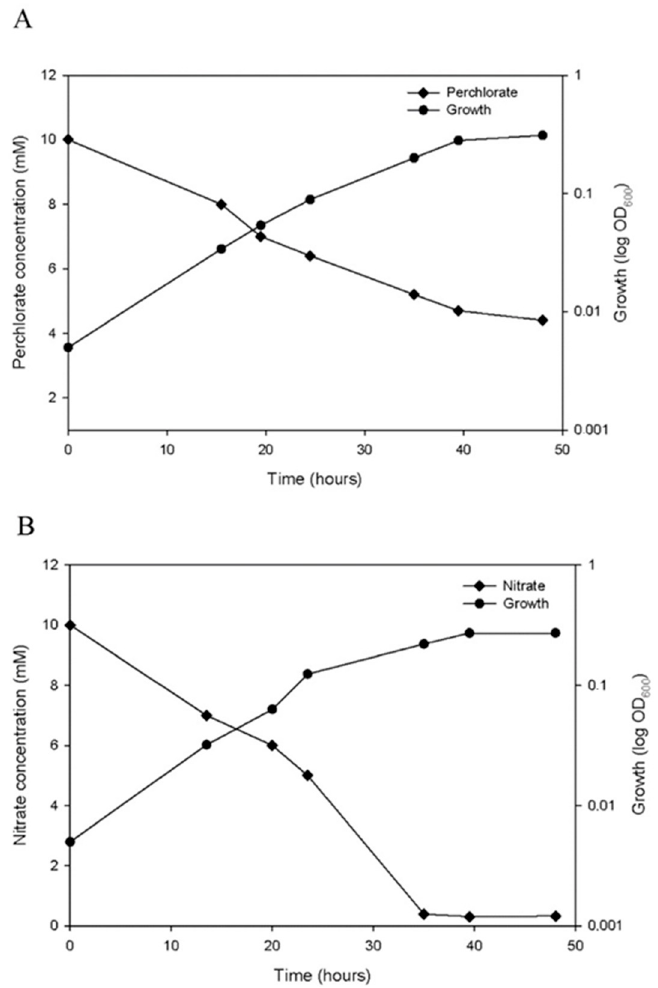
Figure 4. Aerobic perchlorate and nitrate utilization. Aerobically grown strain at exponential phase was inoculated at 0.005 OD600 mL − 1 in fresh minimal medium in aerobiosis at presence of either perchlorate ( A ) or nitrate ( B ), and kinetics of the growth and perchlorate/nitrate utilization were calculated. Each value represents the average of three experiments.